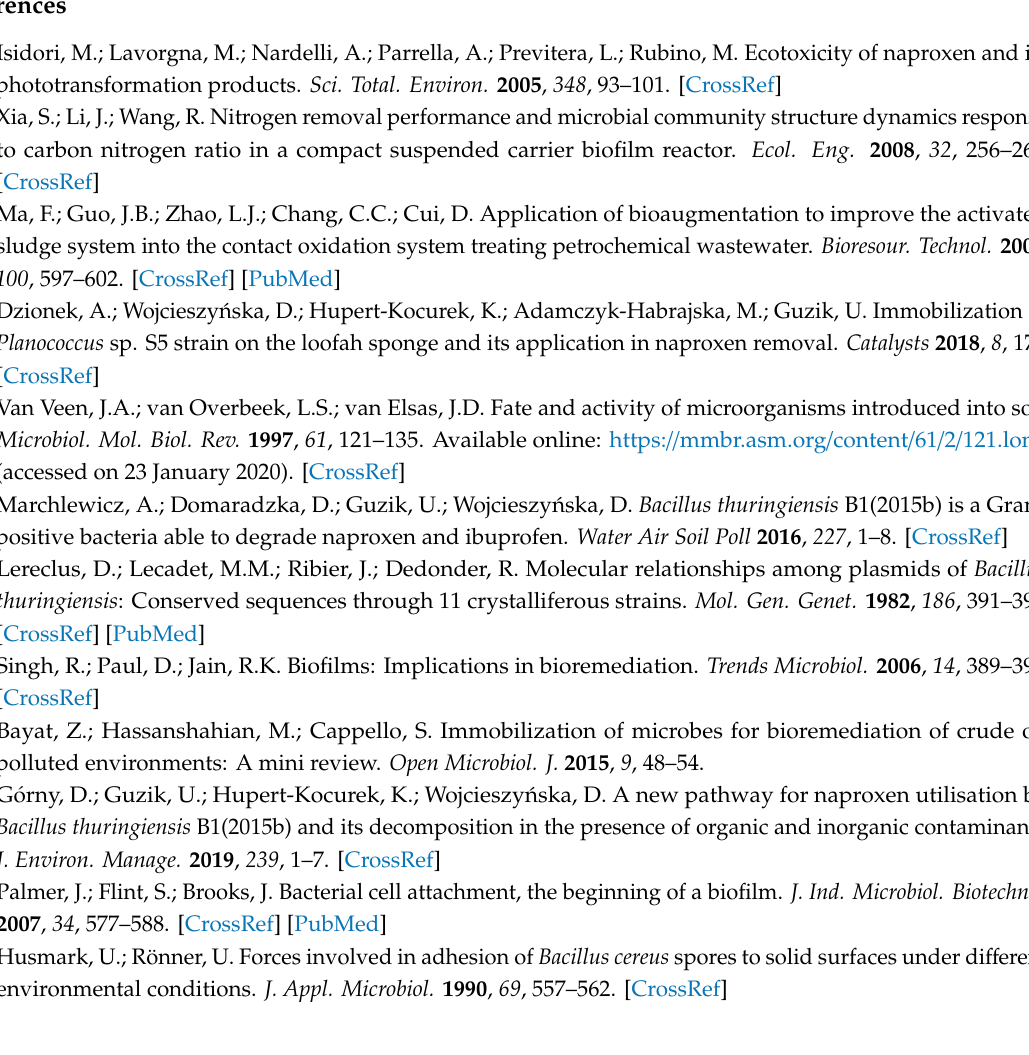
Supplementary Materials: The following are available online: Figure S1: Influence of di ff erent variants of environmental and physiological factors on the immobilisation e ffi ciency of Bacillus thuringiensis B1(2015b) cells on loofah